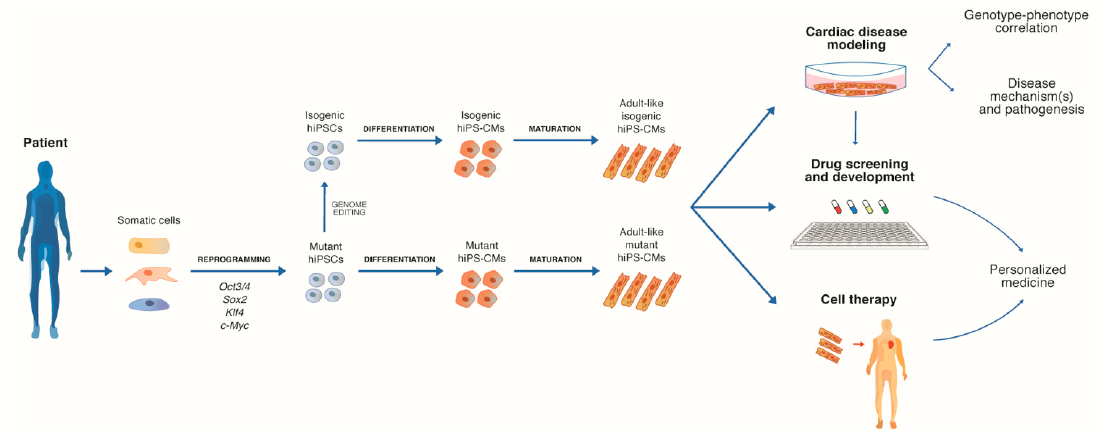
Figure 1. Schematic overview of patient-derived human-induced pluripotent stem cells–derived cardiomyocytes (hiPS-CMs) generation. The process consists of the following three main steps: reprogrammingofsomaticcellsinhumaninducedpluripotentstemcells(hiPSCs); hiPSCsdi ff erentiation in hiPSC-derived CMs; and maturation approaches to obtain adult-like hiPS-CMs. The resulting hiPS-CMs are ultimately used for research studies and clinical